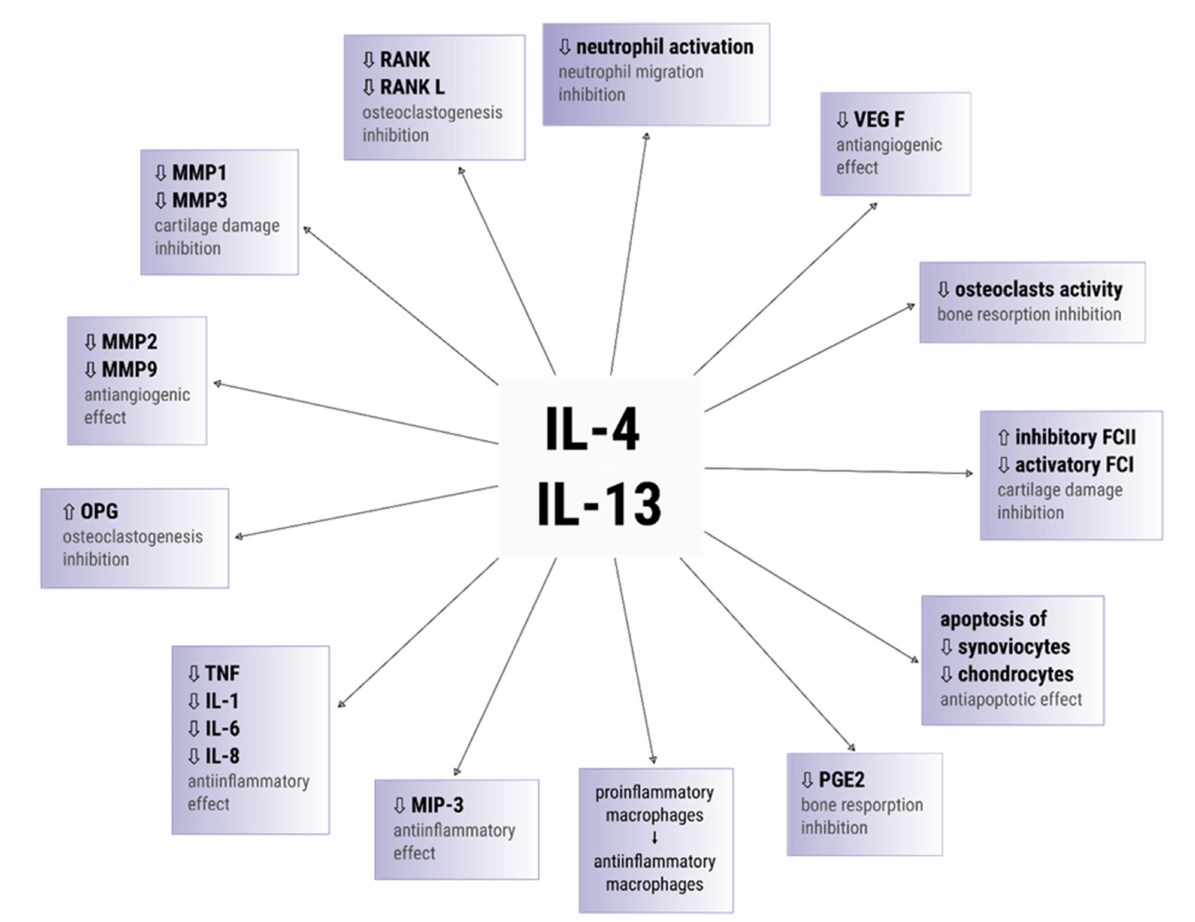
Figure 3. IL-4/IL-13 functions in inflammatory